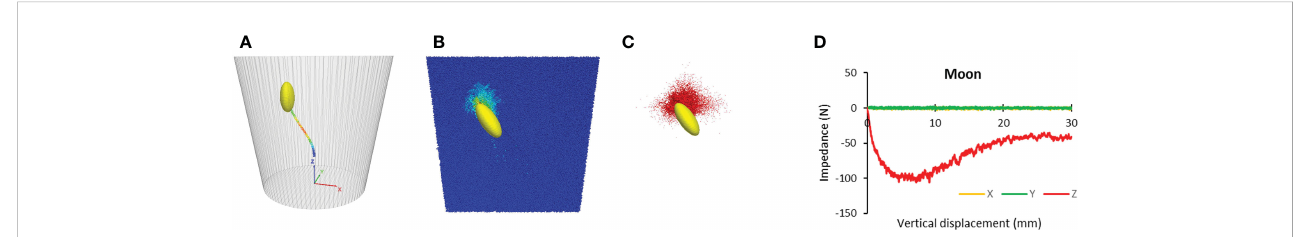
FIGURE 13 Simulated paths and resistances for Lunar soil. (A) Trajectory. (B) Particle velocity contours of soil particles. (C) contact force chains within the soil particles. (D) Resistances to